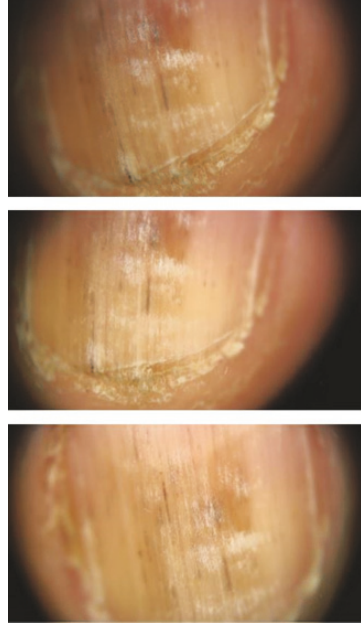
Figure 2: Dermoscopic evaluation of right second nail yields longitudinal gray regular lines on a grayish background, splinter hemorrhages as blackish linear streaks, and true leukonychia as it